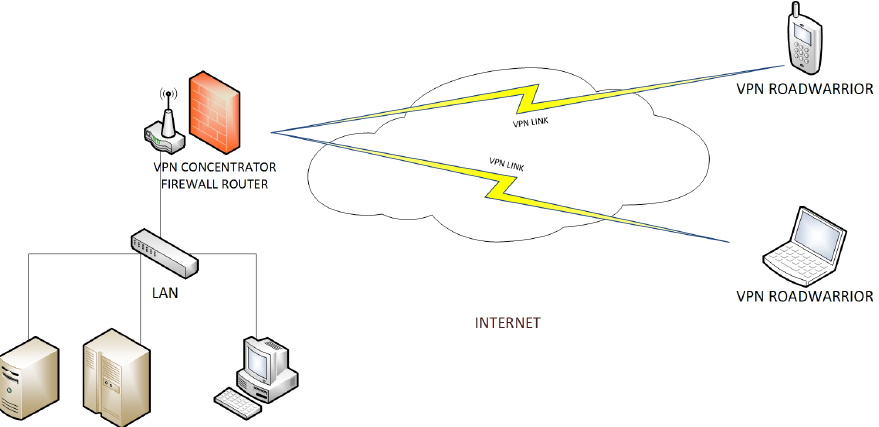
Figure 4. Site to Road Warriors VPN